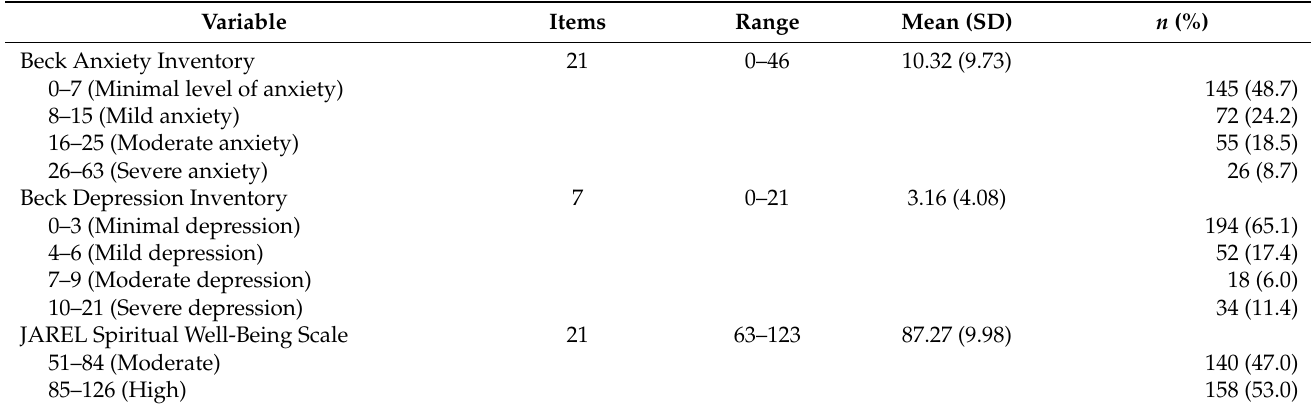
Table 2. Mental and spiritual characteristics of hemodialysis patients ( n = 298).